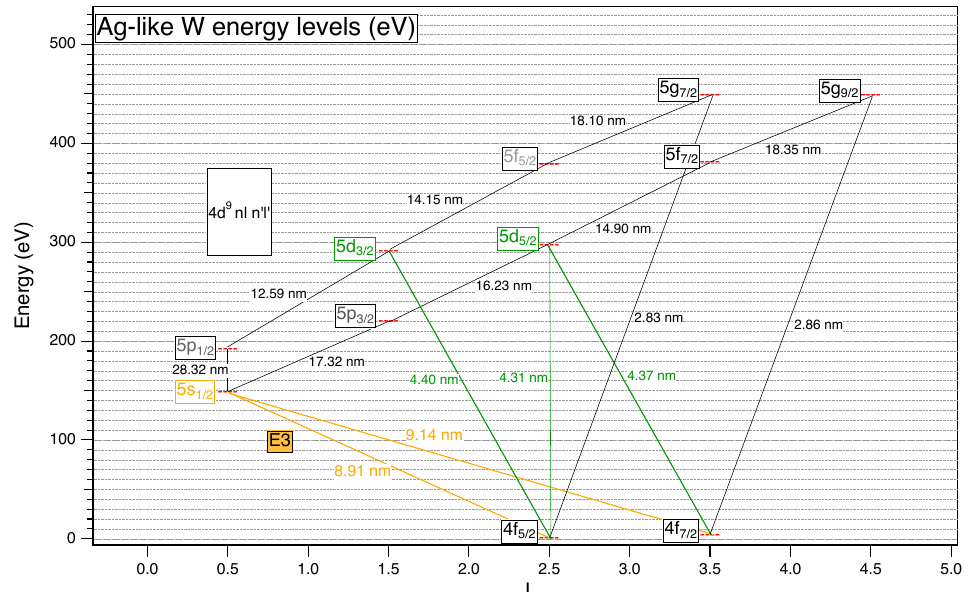
Figure 2. Low-lying energy levels and transitions in Ag-like tungsten ions. E1 wavelengths are calculated with the FAC [7] and E3 wavelengths by the GRASP2K [8] atomic structure